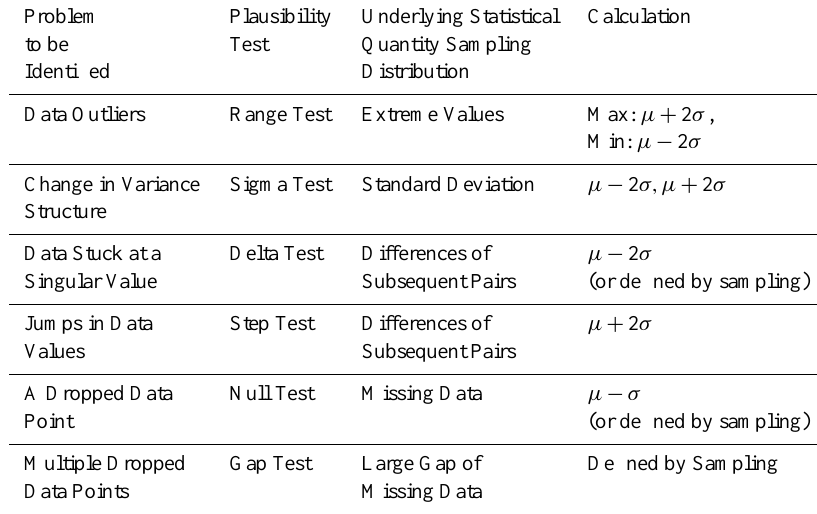
Table 2. The six plausibility tests employed in the first phase of NEON’s data quality control. Problem Plausibility Underlying Statistical to be